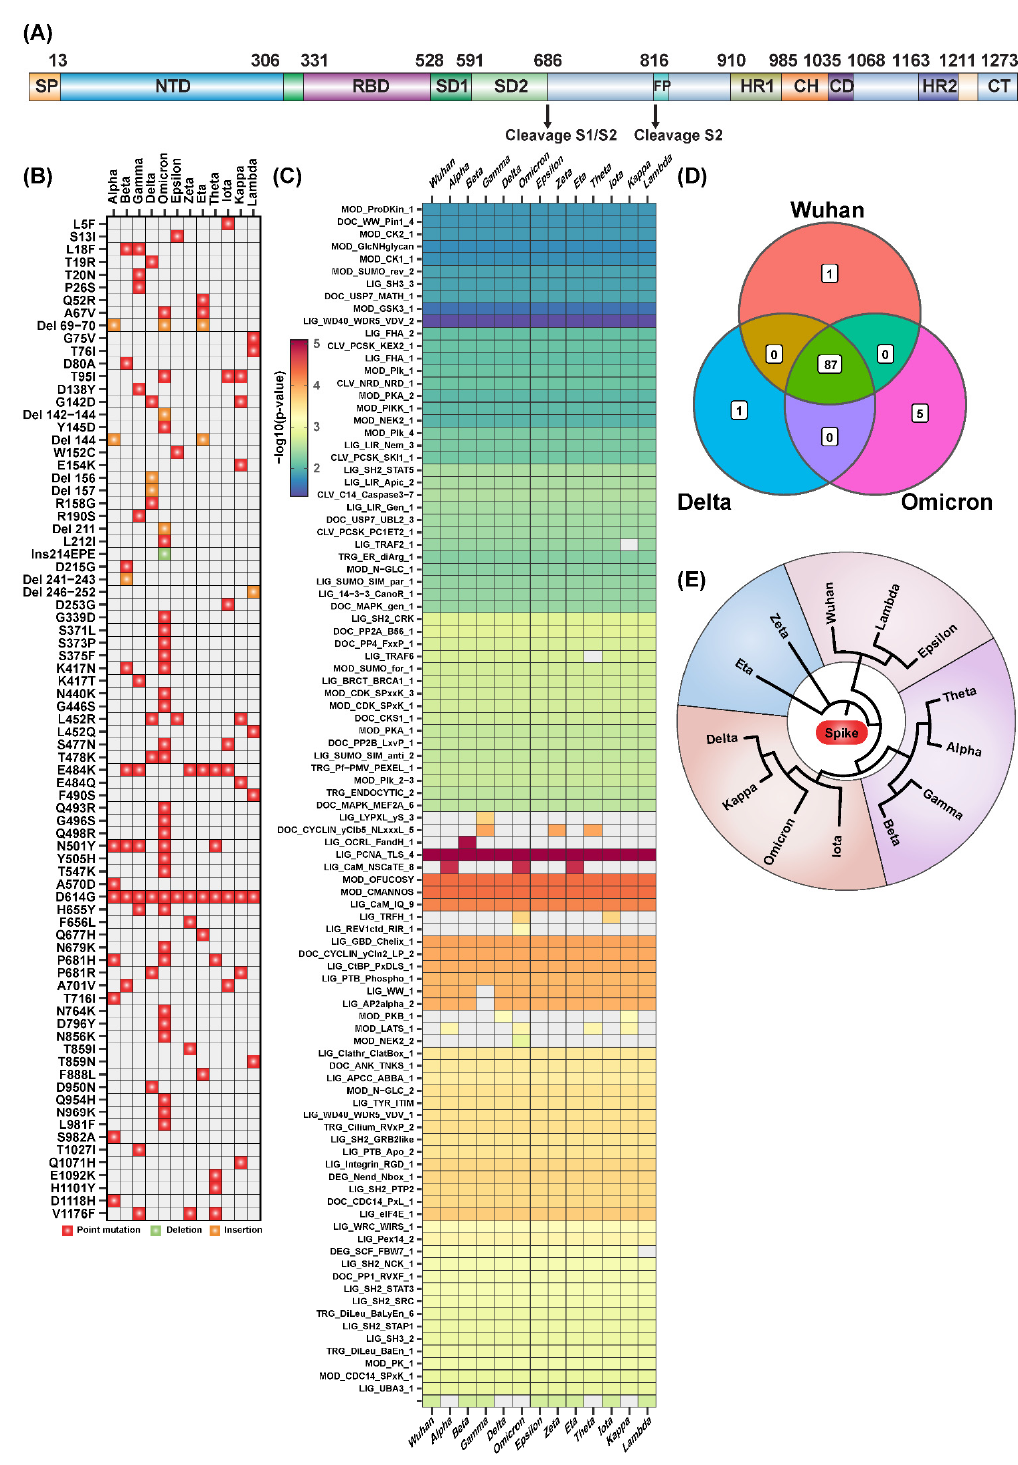
Figure 1. Domain organization and SLiMs in SARS-CoV-2 variants. ( A ) Protein domain organization of spike protein. The S-protein contains the N-terminal domain (NTD), receptor binding domain (RBD), subdomain 1 (SD1), subdomain 2 (SD2), fusion peptide (FP), heptad repeat 1 (HR1), central helix (CH), connector domain (CD), heptad repeat 2 (HR2), and cytoplasmic tail (CT). ( B ) Matrix of mutations on spike protein across SARS-CoV-2 variants. ( C ) Heatmap summarizing the identified SLiMs across SARS-CoV-2 variants. ( D ) Venn diagram showing the overlap of SLiMs of the spike protein from Wuhan, Delta, and Omicron variants. ( E ) A circular dendrogram showing the similarity of the spike protein from SARS-CoV-2